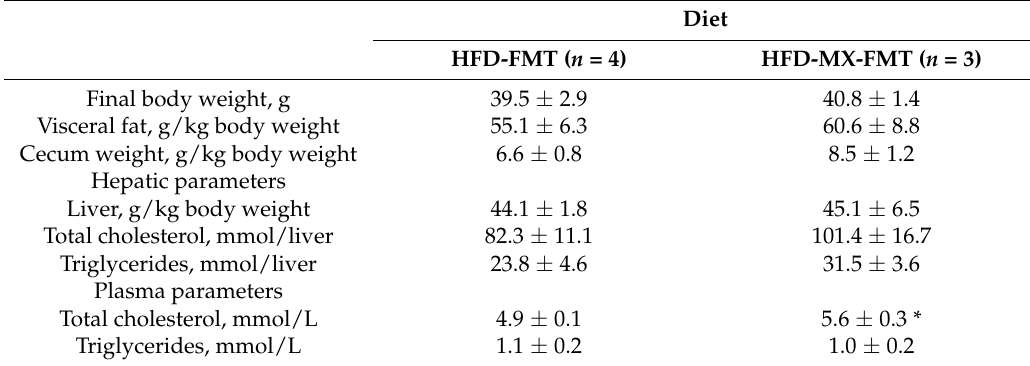
Table 3. Body weight, organ weight, and plasma parameters of mice fed the high-fat diet following fecal transplantation from mice fed a high-fat diet with or without